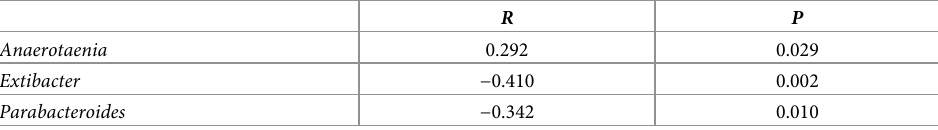
Table 3. Correlation analysis between the gut microbiota abundance and the PSQ total score (n =